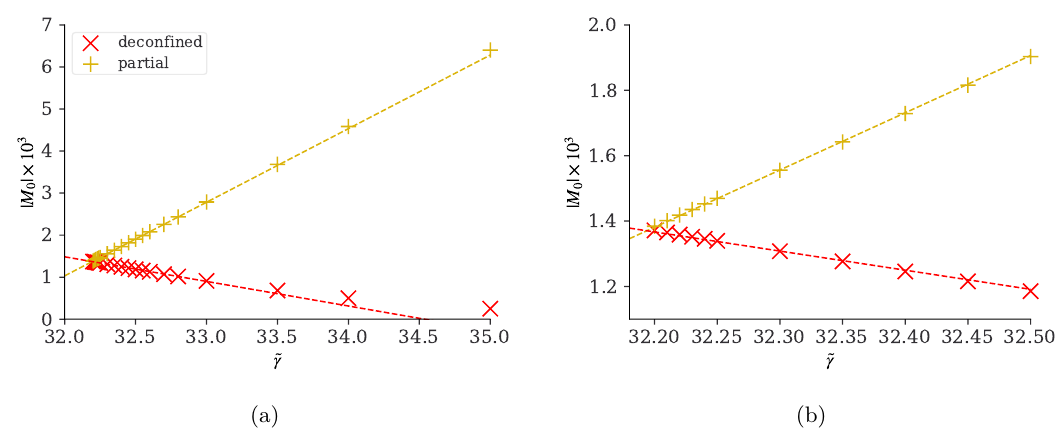
Figure 11. (a) θ = π numerical results for | M 0 | , magnified by a factor of 10 3 for clarity, as a function of ˜ γ , for N = 30 , in the deconfined phase (red crosses) and partial phase (gold plus signs). | M 0 | in the deconfined phase becomes zero in the large- N limit. The gold plus signs have larger values, showing that our solutions indeed describe a partial phase. (b) Close-up of (a) near the transition point.